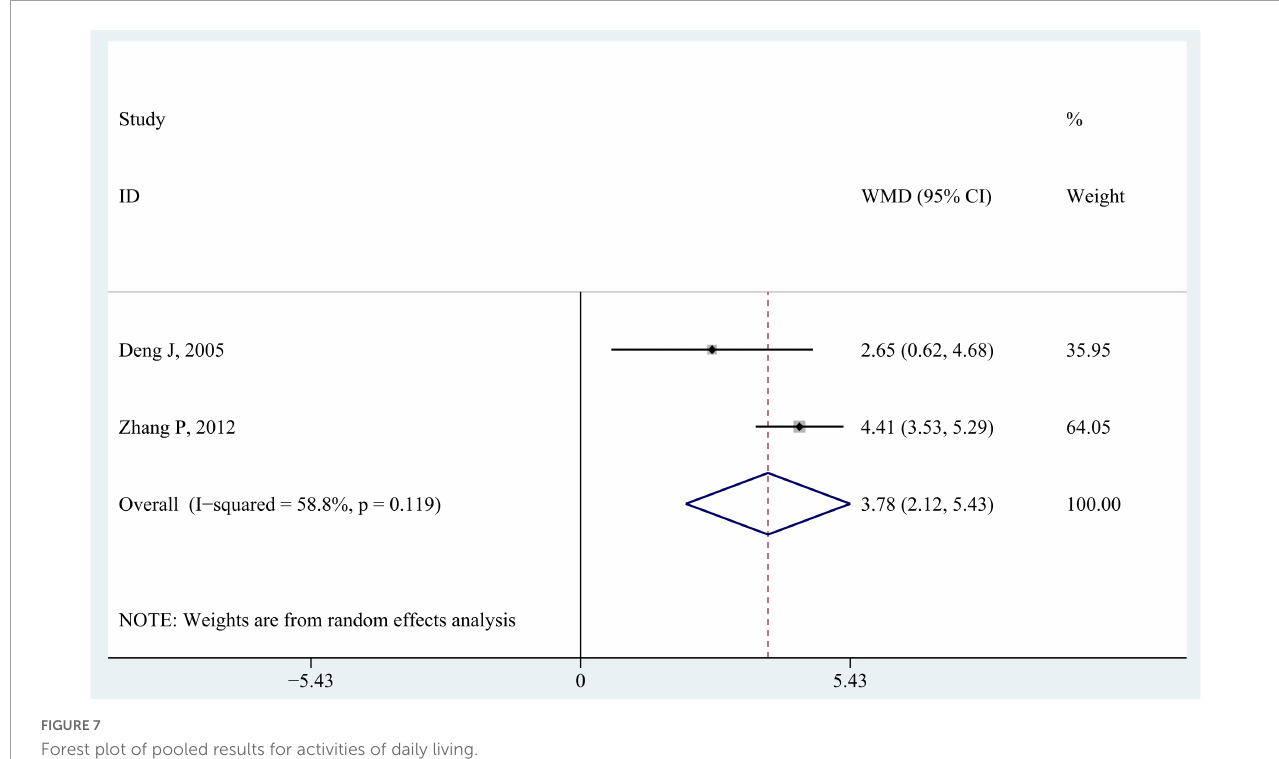
FIGURE7 Forest plot of pooled results for activities of daily living.